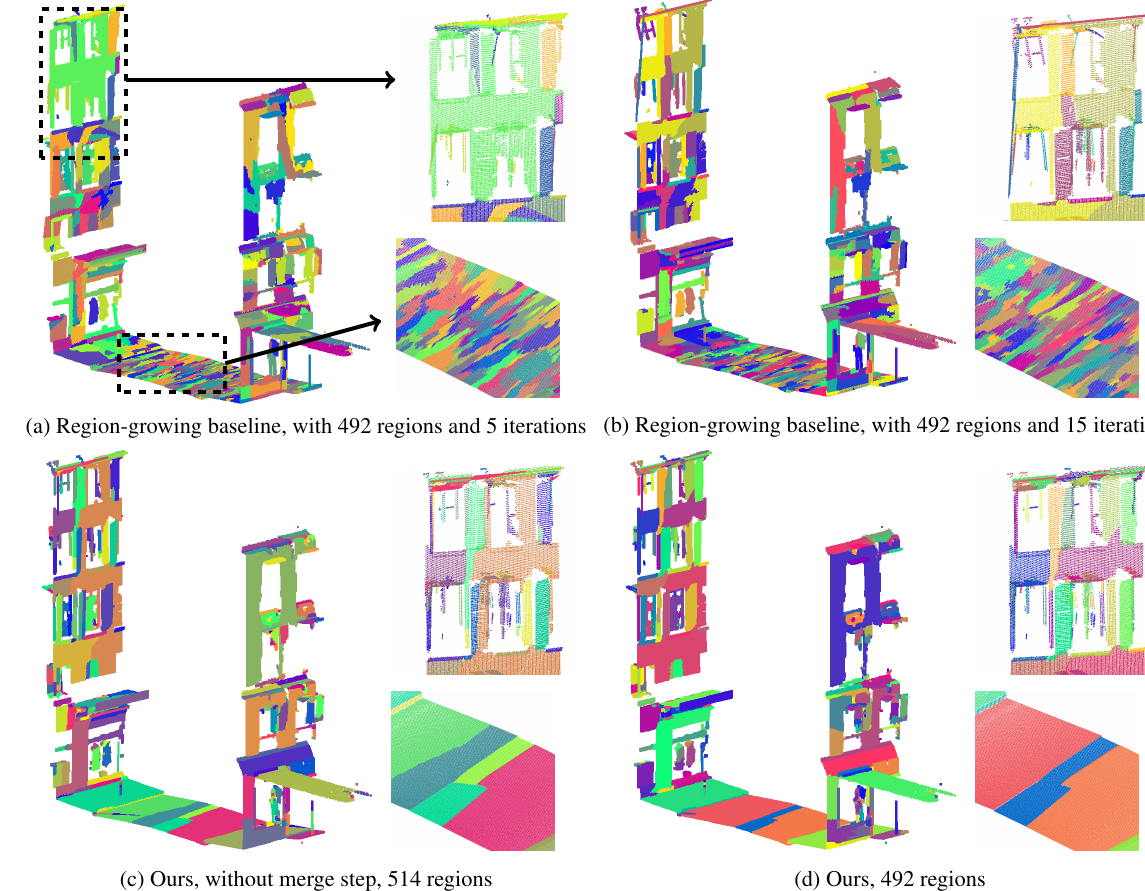
Figure 2. Comparison of our method and the baseline. Each color represent a different region. Points are projected on the plane supporting their region. Each result comes with a close picture of a building and a road portion. Our method creates large regions on simple parts of the cloud, in order to be more adaptive on complex parts.